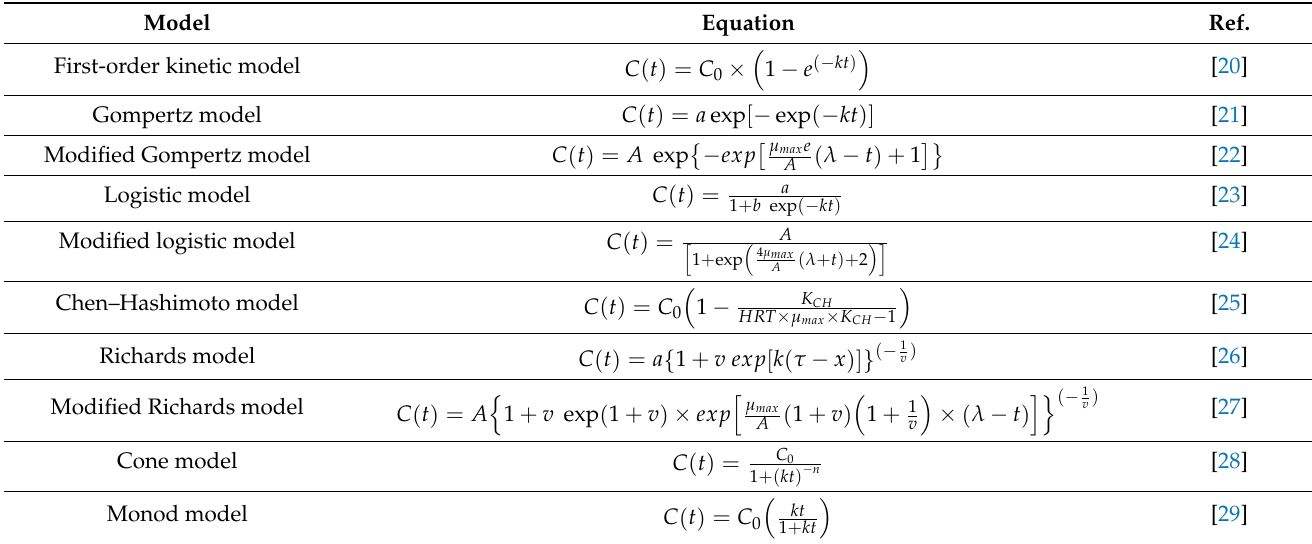
Table 4. Most common kinetic models used for AD process reaction